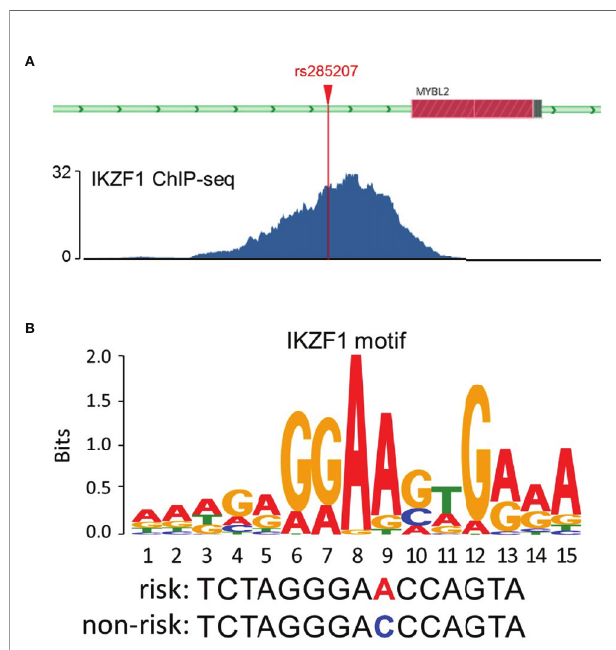
FIGURE 2 | rs285207 modulated the binding to IKZF1. (A) IKZF1 ChIP-seq signals at the rs285207 locus in GM12878 cells. (B) Predicted preferential binding of IKZF1 to the risk allele A of